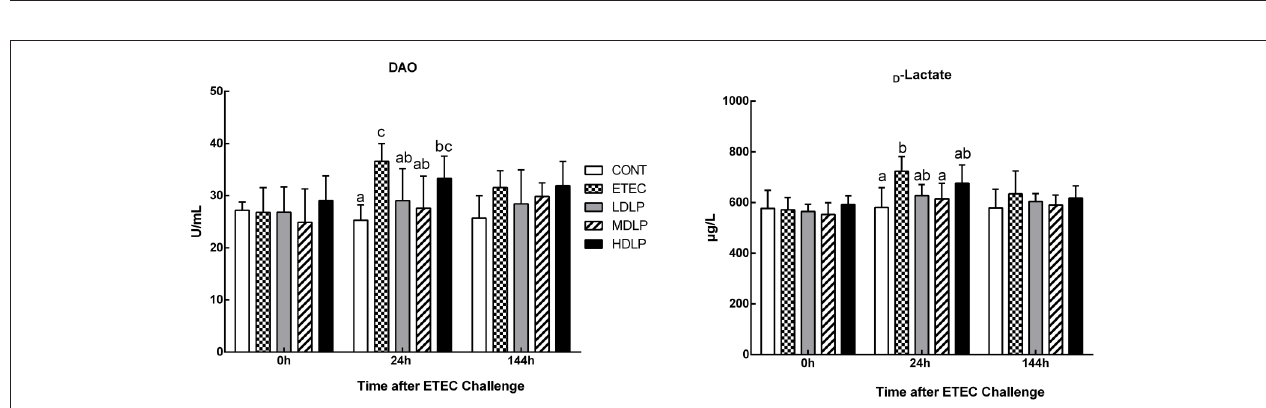
FIGURE 3 | Dose effect of Lactobacillus plantarum on DAO activity and D -lactate concentration in serum of mice during pre- and post-challenge periods. CONT, control group, treatment with PBS at all period; ETEC, negative group, oral challenge with ETEC on day 15; LDLP, low dose (5.0 × 10 8 cfu mL − 1 ) group;